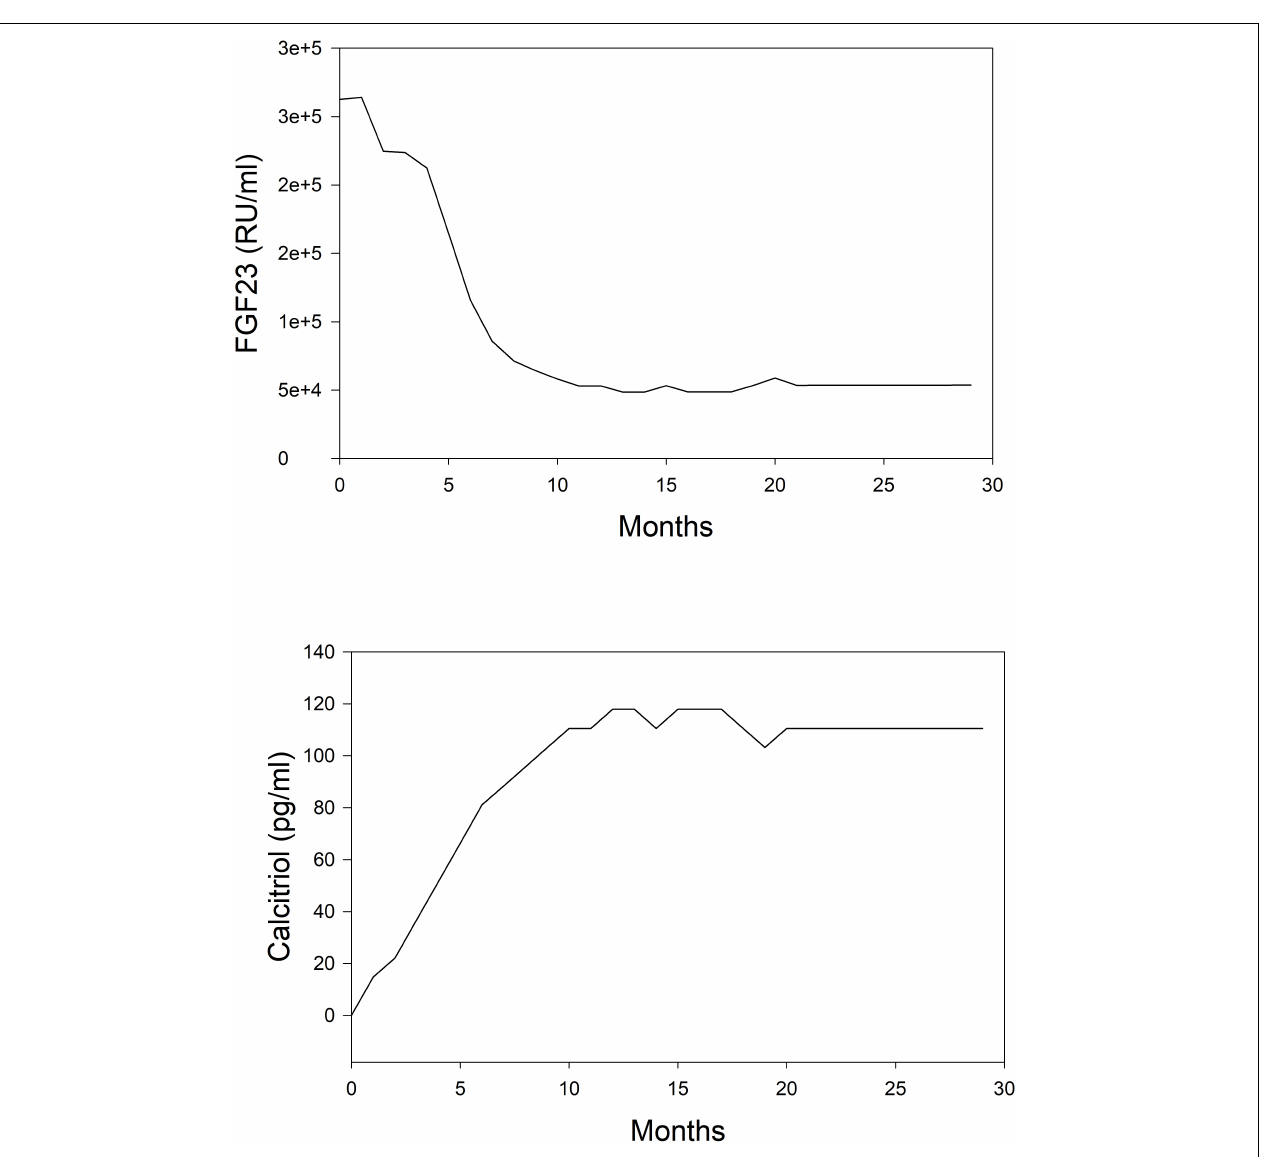
FIGURE 3 | Simplified depiction of the predicted time course of non-routinely measured markers of mineral metabolism in the simulated (in silico ) treatment of CKD-MBD using phosphate binder, vitamin D analog, and a calcimimetic. Top panel, FGF 23; Bottom panel, calcitriol.